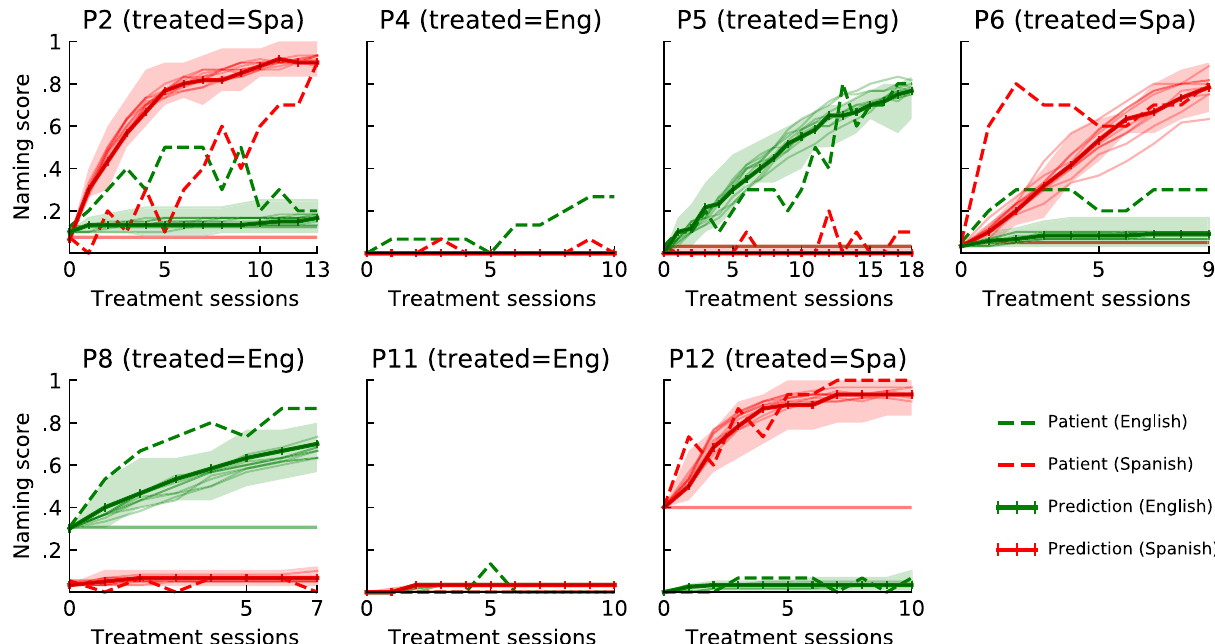
Figure 6. Robustness of the simulated results. For a representative subset of patients from the diagonal of Fig. 5, model variation is illustrated in two ways. First, the five best BiLex treatment models found by the evolutionary algorithm were identified based on their prediction accuracy on the training set; the median predictions of these models are shown in thin solid lines. Second, the minimum/maximum ranges over ten treatment simulations of the most accurate model are shown by the shaded area. There is very little variation across models and within the best model, demonstrating that the modeling approach is